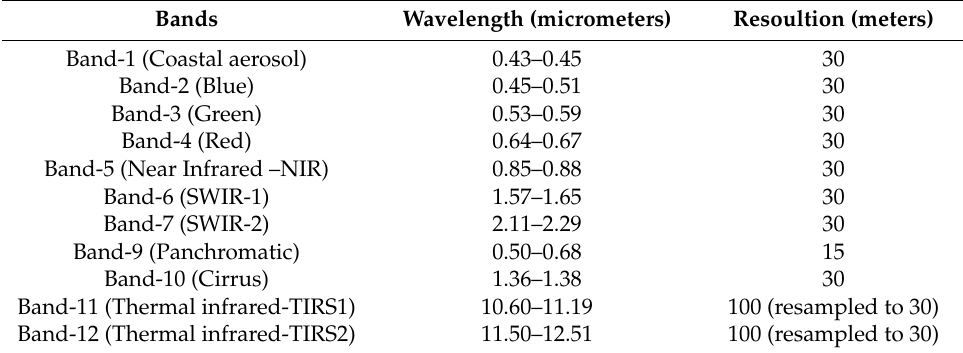
Table 1. The Landsat-8 sensors, the operational land imager (OLI), and the thermal infrared sensor (TIRS) spectral bands and their spatial